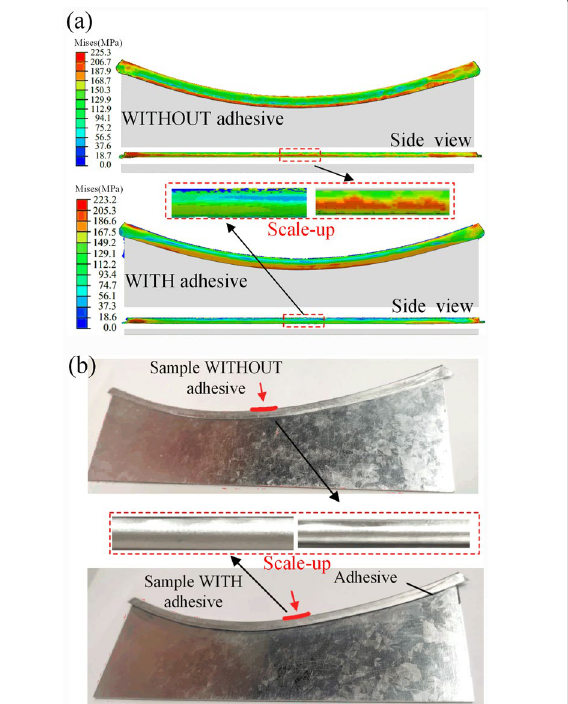
Figure 13 Experiment samples with and without adhesive after roller hemming